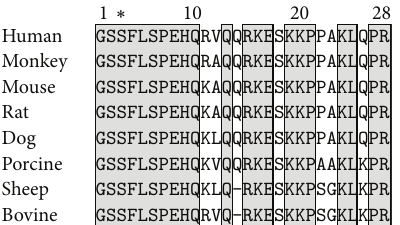
Figure 2: Sequence homologies between mammalian ghrelin. Highlighted boxes indicate amino acid homologies among ghrelin from mammalian species. The acylation of ghrelin on the third conserved serine is indicated by a ∗